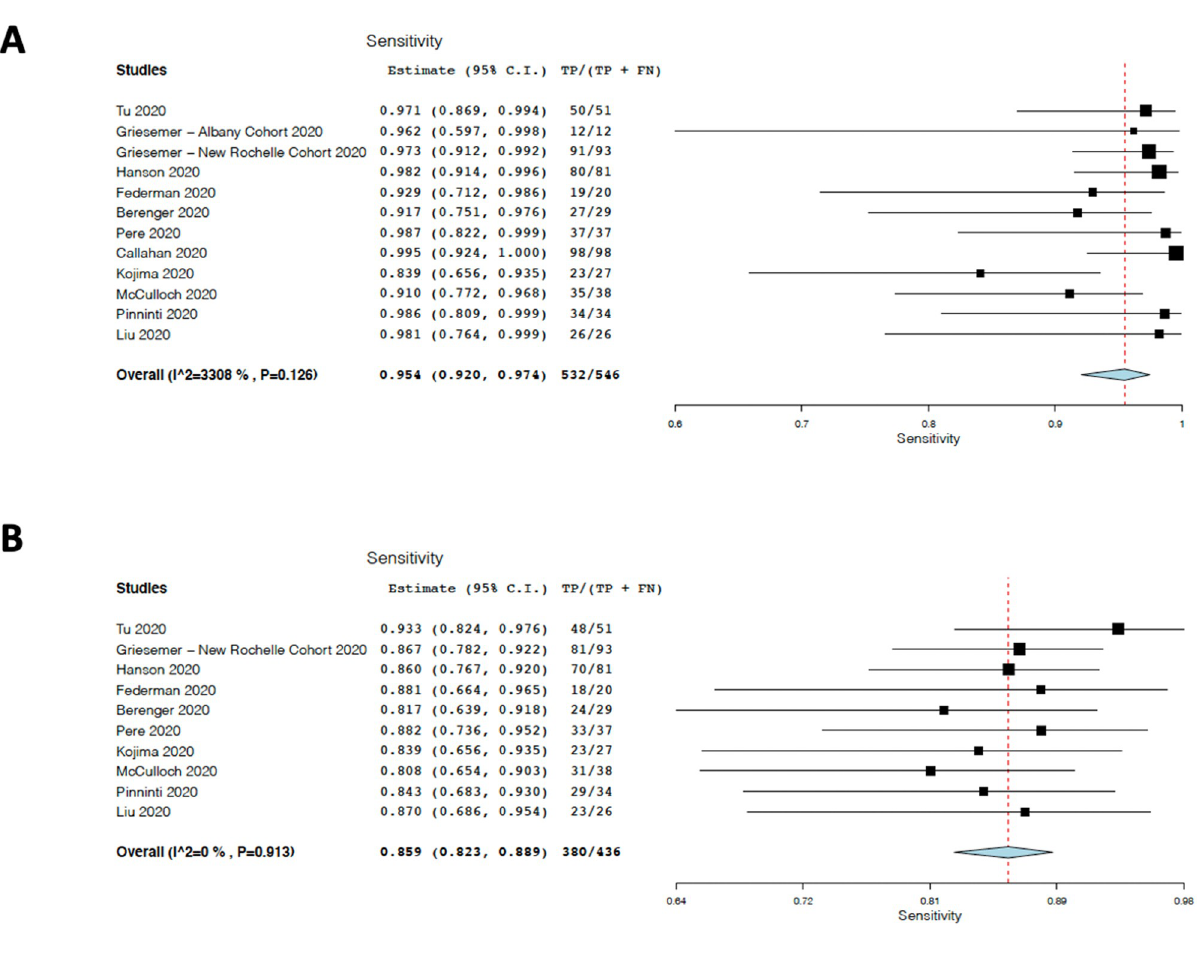
Fig 3. Computer results from unplanned exploratory analysis to include all anterior nasal swab and middle turbinate samples. (A) Results for NPS from all cohorts included in this review. (B) ANS+MTS from all cohorts except the Griesemer [9] Albany cohort and the Callahan [3] cohort. Only ANS results are included from the Tu study